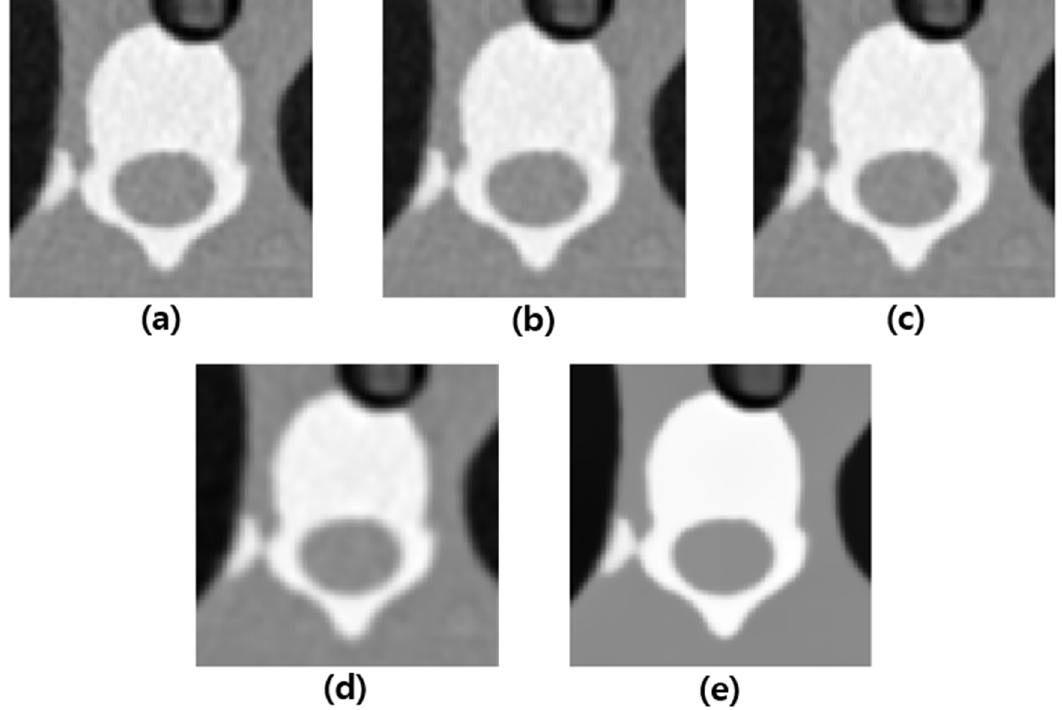
Figure 6. Magnified views (region inside the blue box). ( a ) Original; ( b ) Gaussian filtered; ( c ) Median filtered; ( d ) Wiener filtered; ( e ) FNLM filtered images.